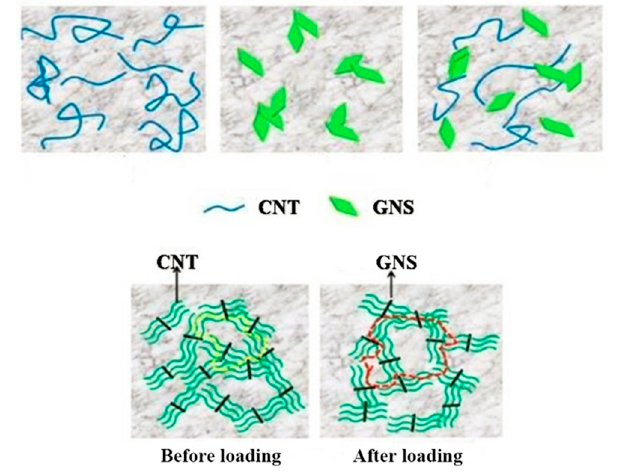
Figure 8. Schematic images of the reinforcement dispersion in the epoxy composites.